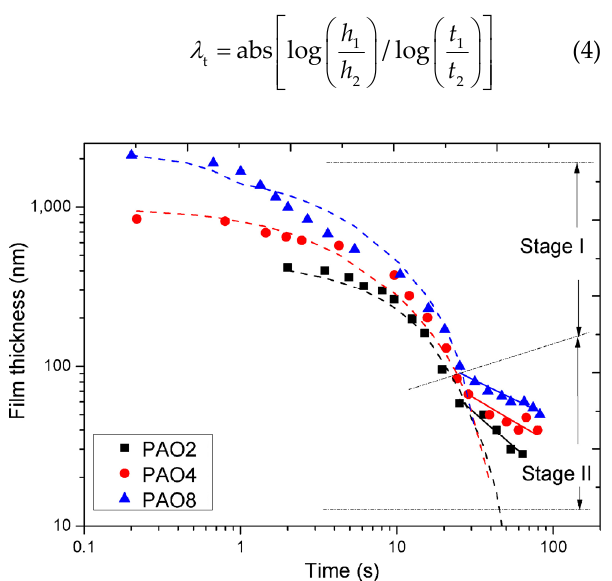
Fig. 6 Measurements of starved central film thickness against time after the oil supply is suspended for three different oil, pure rolling, p H = 431 MPa, t 0 = 25